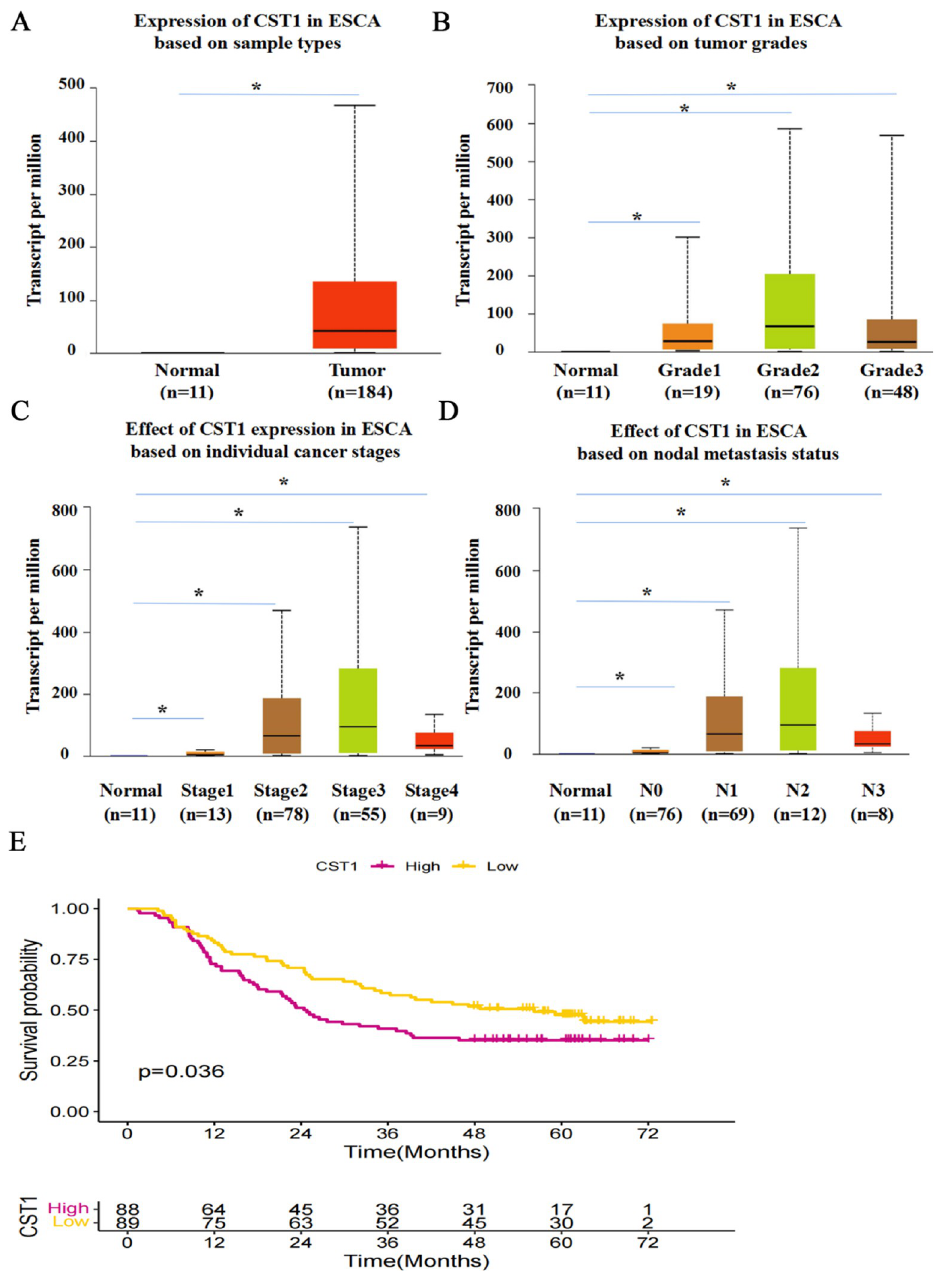
Fig 1. Expression of CST1 in esophageal cancer by TCGA. (A) Expression of CST1 in patients with esophageal cancer and normal subjects. (B) Expression of CST1 in patients with all grades of esophageal cancer. (C) Expression of CST1 in patients with all stages of esophageal cancer. (D) Expression of CST1 in patients with different lymph node metastases of esophageal cancer. (E) Survival probability of esophageal cancer patients with different levels of CST1 expression. ( � P <